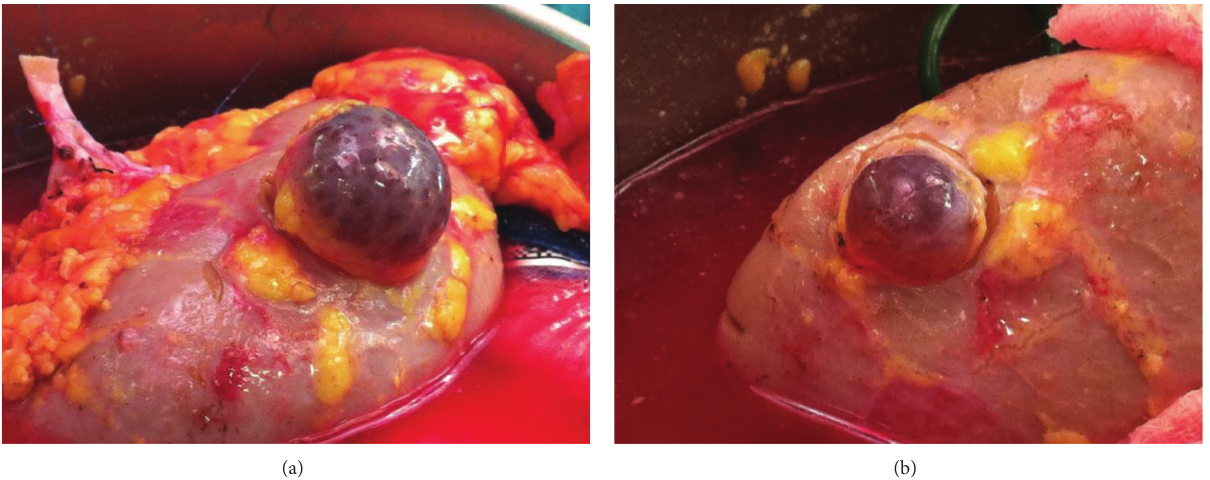
Figure 2: Renal cortical cysts located in the upper pole (a) and lower pole (b) of